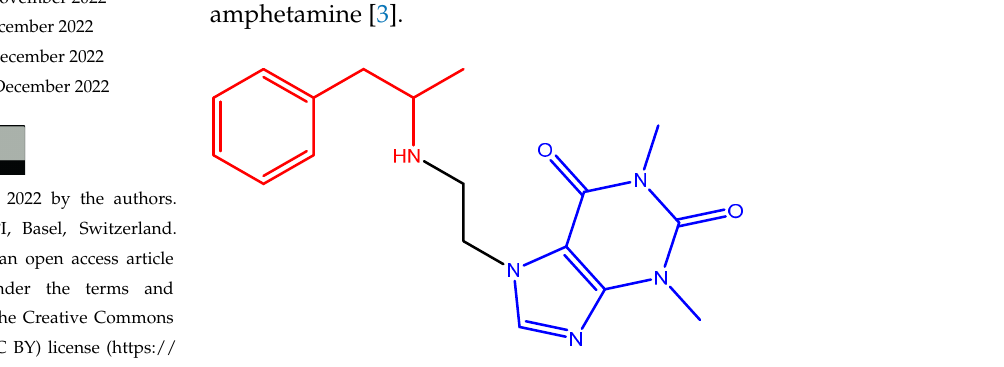
Figure 1. Structural formula of captagon.